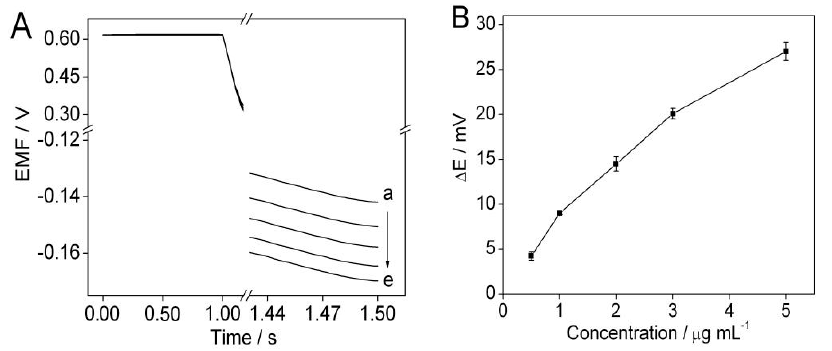
Figure 3. ( A ) Potentiometric responses of the solid-contact polycation-sensitive membrane electrode in 1.5 mL of 0.01 M sodium chloride solution with different protamine concentrations of ( a ) 5; ( b ) 3; ( c ) 2; ( d ) 0.5; and ( e ) 0 μ g·mL − 1 . ( B ) Plot shows potential changes over the protamine concentration